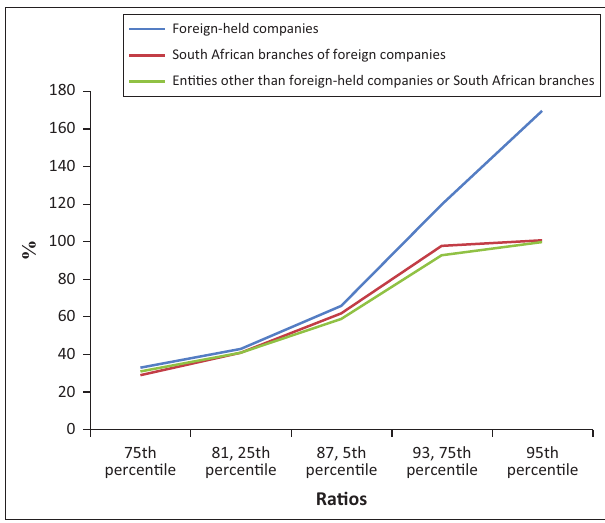
FIGURE 3: Trend in interest-to-earnings before interest, taxes, depreciation, and amortisation (EBITDA) ratio for 75th percentile and upwards in companies with turnover exceeding R20